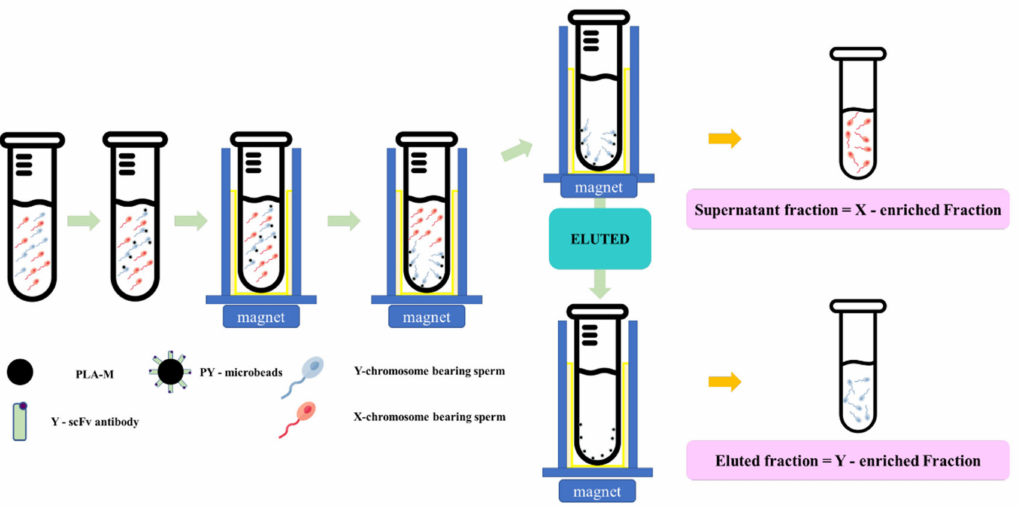
Figure 1. The schematic magnetic-activated cell sorting protocol for bovine sperm by using